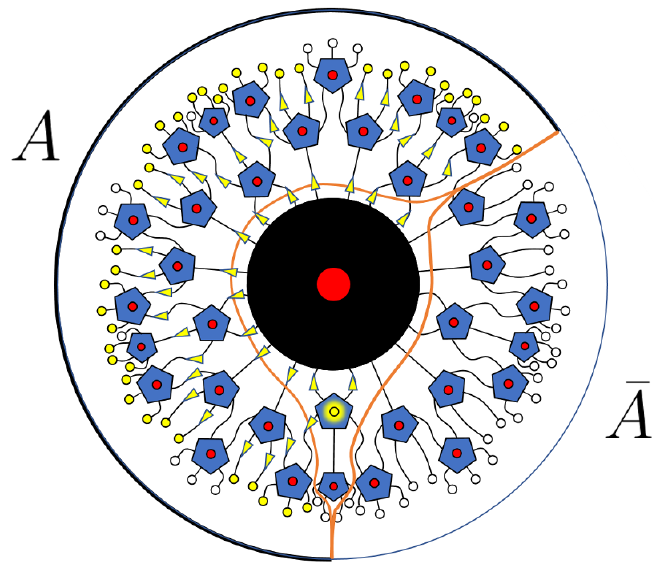
Figure 9 . An example of an operator that can only be pushed to region A of the boundary through the black hole. This can only be achieved if the space of microstates is small enough for the black hole to act approximately as an isometry. In this case we have n a = 12, while n (cid:22) a = 6 and n a 0 = 2. As a result we must have log D < 4 log d , or equivalently (cid:11) = 1 5